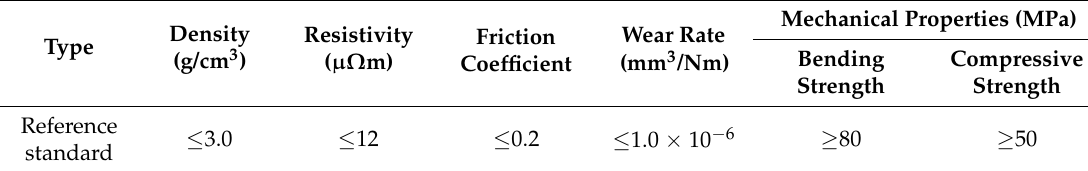
Table 1. Major properties of the industry standard.